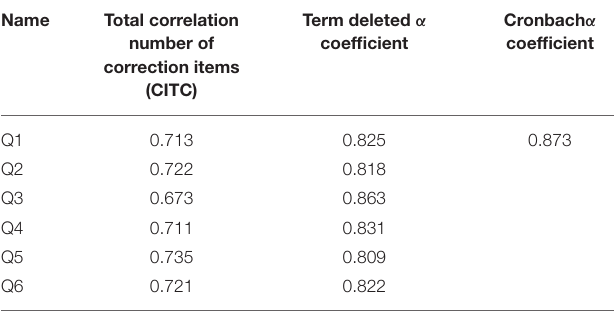
TABLE 1 | Reliability test